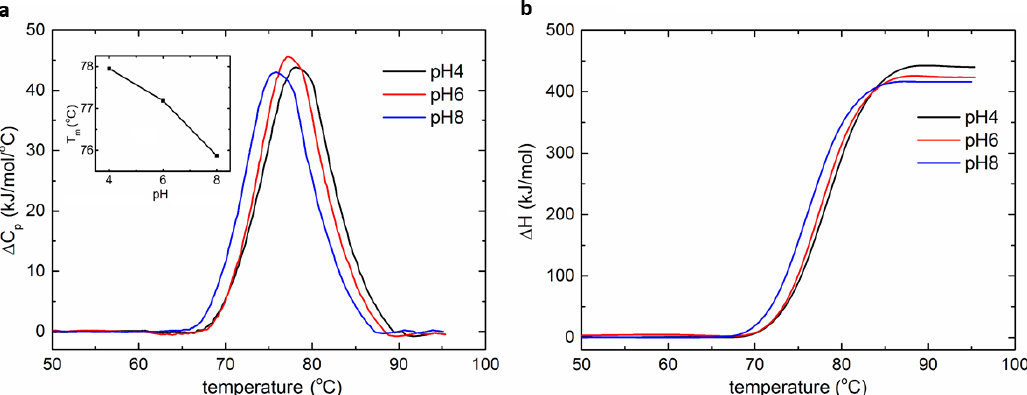
Figure 4. The DSC measurement of lysozyme sample. ( a ) The normalized heat capacity change as a function of temperature. The inset shows the relationship between the transition temperature and pH. ( b ) The normalized enthalpy change as a function of temperature.